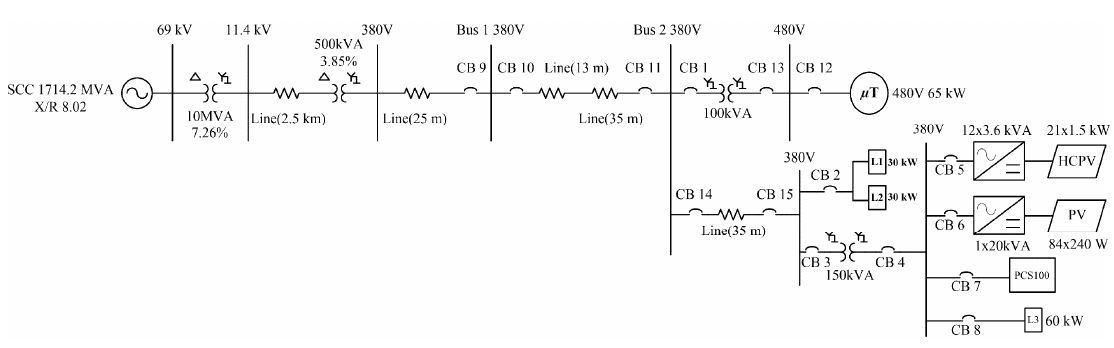
Figure 6. Single line diagram of the test microgrid system with MAS.